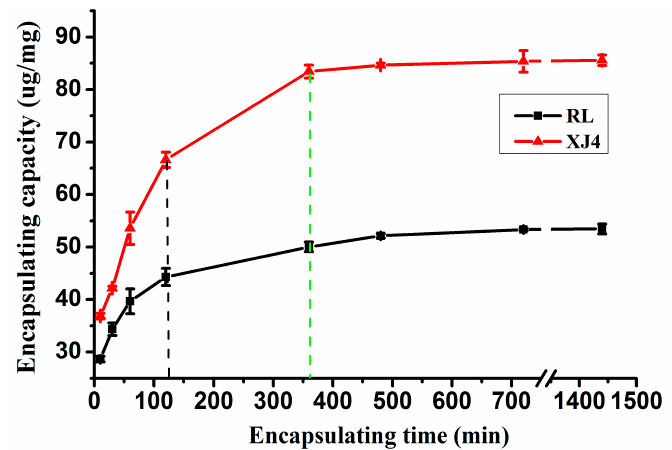
Figure 3. Encapsulating capacity of CSNPs under various encapsulating times of anthocyanins.